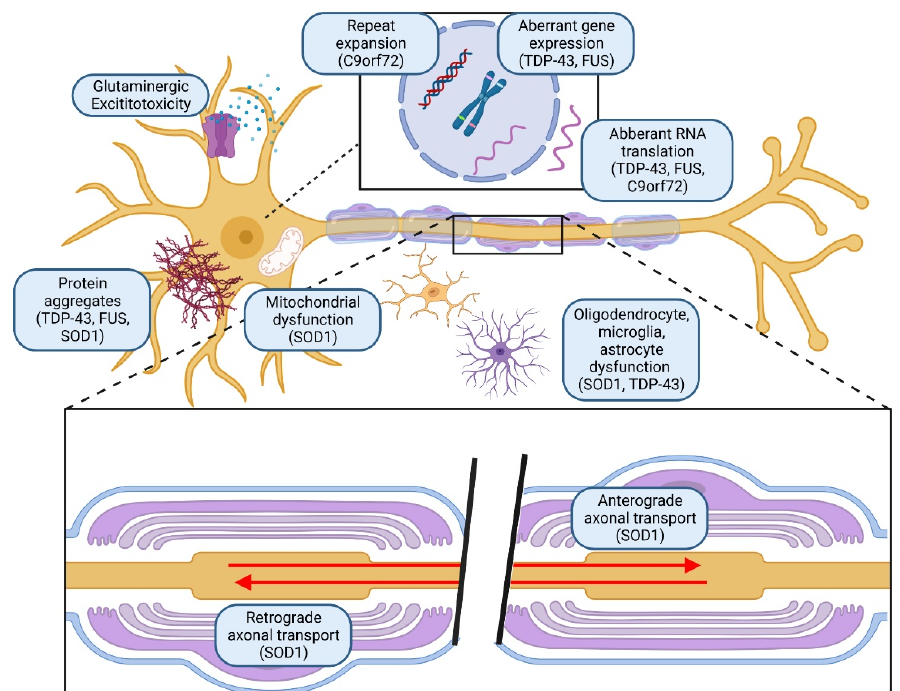
Figure 3. Pathophysiology of amyotrophic lateral sclerosis. The dying forward hypothesis states that ALS results in anterograde corticomotor neuron degeneration. In the dying back hypothesis, mutations in the TDP-43, c9orf72, and FUS genes form intracellular neuronal aggregates. The independent degeneration hypothesis argues that upper and lower motor neuron degeneration occurs independently (created with BioRender.com) (accessed on 8 January 2023).